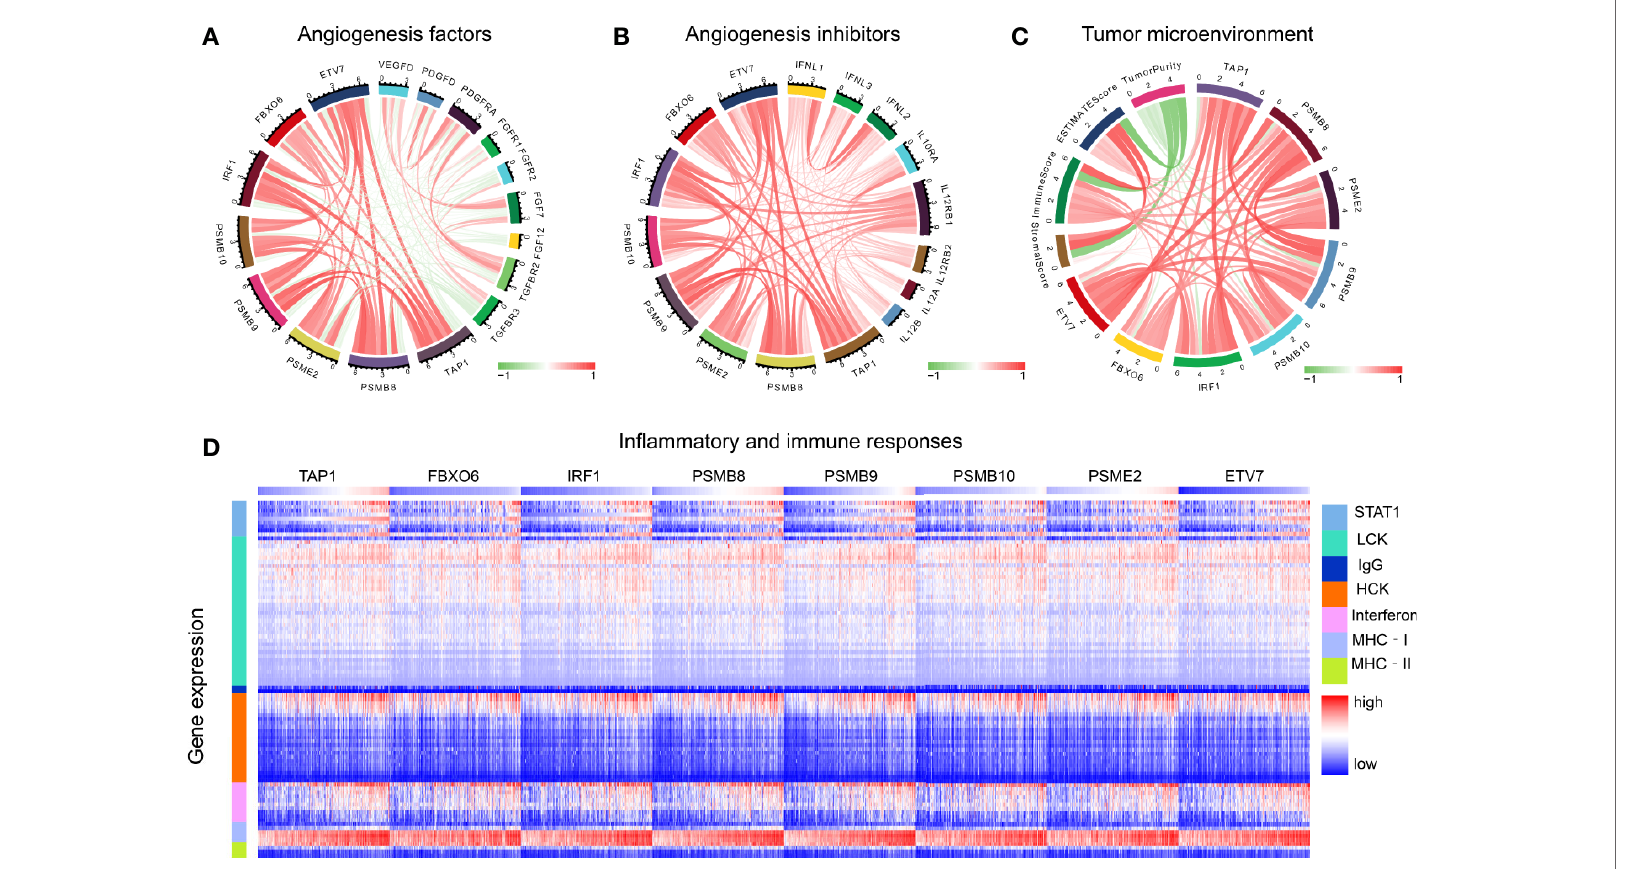
FIGURE 7 | Tumor microenvironment analysis. (A) The correlation of CD8+ T cells in fi ltration promoting genes to angiogenesis factors. (B) The correlation of CD8+ T cells in fi ltration promoting genes to angiogenesis inhibitors. (C) The correlation of CD8 + T cell in fi ltration-promoting genes to tumor purity. (D) The correlation of CD8 + T cell in fi ltration-promoting genes to in fl ammatory and immune responses. These responses were induced by lymphocyte ‐ speci fi c kinase (LCK), hemopoietic cell kinase (MCK), major histocompatibility complex class I (MHC ‐ I), immunoglobulin G (IgG), major histocompatibility complex class II (MHC II), signal transducer, activator of transcription 1 (STAT1), and